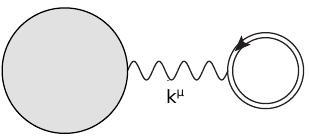
Figure 9 . The one-loop tadpole correction to any